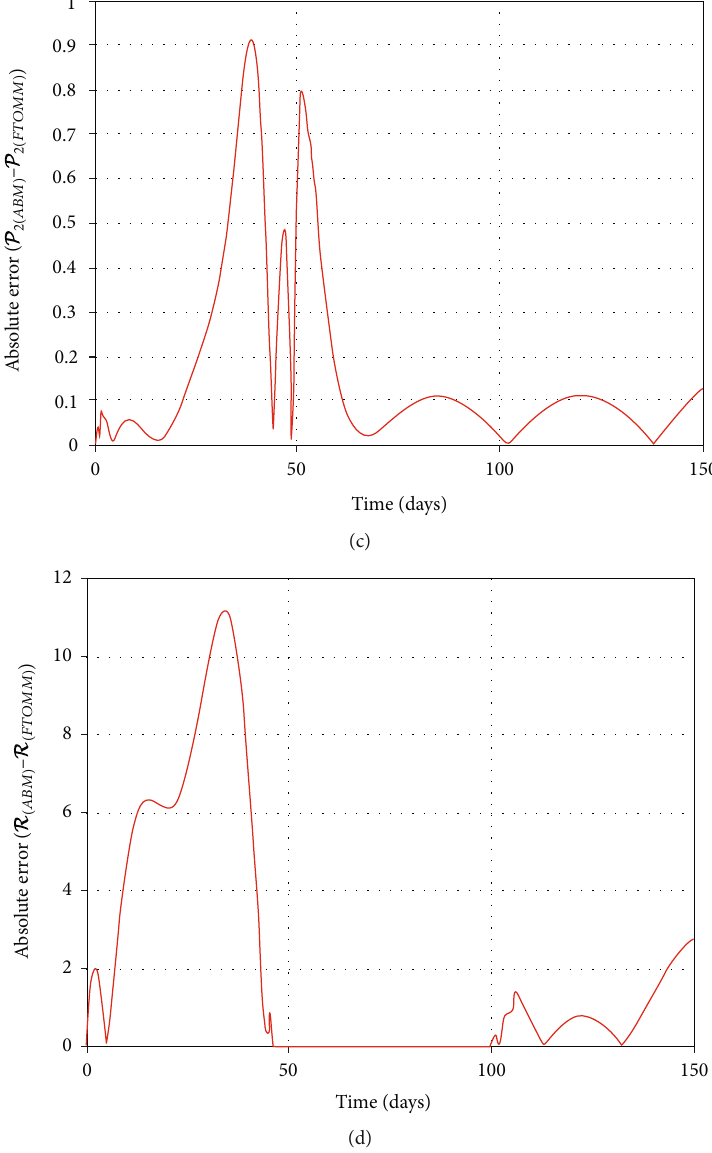
Figure 9: Absolute error comparisons between the ABM and FTOMM for the parametric